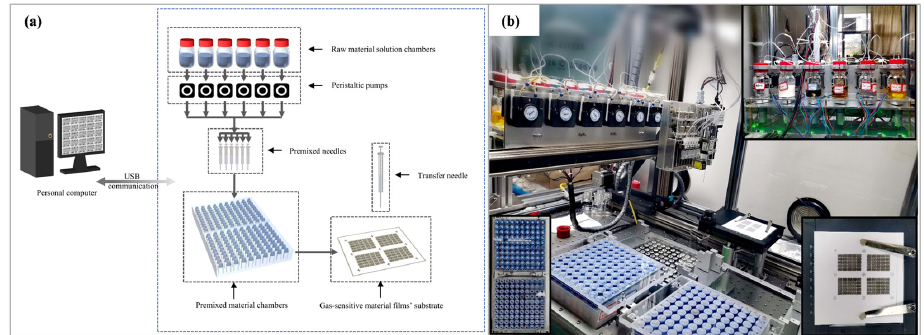
Figure 2. Parallel synthesis of gas-sensitive films, ( a ) Schematic diagram, ( b ) Physical diagram.